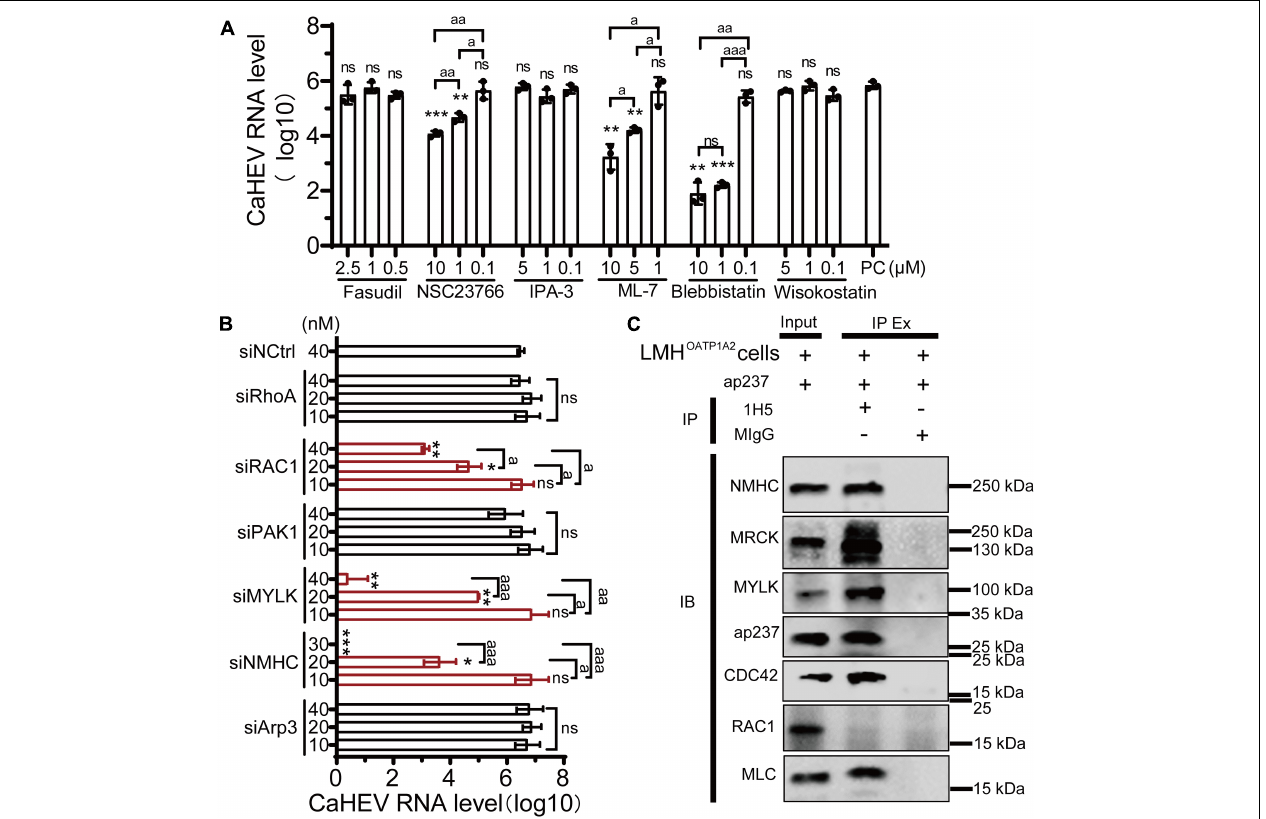
FIGURE 4 | CDC42/RAC1-NMIIA signaling pathway is involved in avian infection. (A) Copies of CaHEV RNA in infected LMH OATP1A2 cells treated with different concentrations of Fasudil, NSC23766, IPA-3, ML7, wiskostatin, and blebbistatin. At 7 dpi, CaHEV ORF3 RNA was detected by qPCR. (B) Copies of CaHEV in infected LMH OATP1A2 cells transfected with different concentrations of siRhoA, siRAC1, siPAK1, siMYLK, siNMHC, and siArp3, respectively. (C) The ap237 pulled down the molecules in the CDC42-MRCK-MYLK-NMIIA signaling pathway. NMHC, NMIIA heavy chain. MLC, NMIIA light chain. MYLK, myosin light chain kinase. MIgG was set as blank control. ns, no significant; * and a, P < 0.05; ** and aa, P < 0.01; *** and aaa, P <